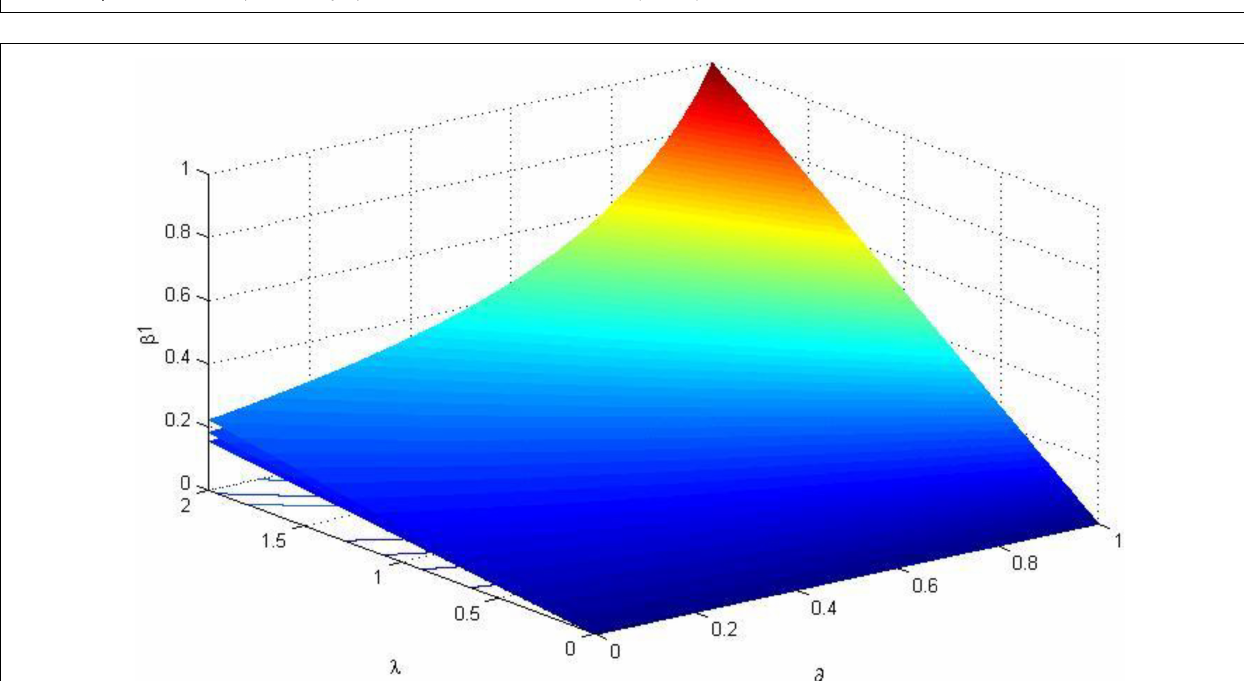
FIGURE 2 | The trend of the incentive coefficient of the first-ranked worker β 1 ( σ 2 = 0 . 8).